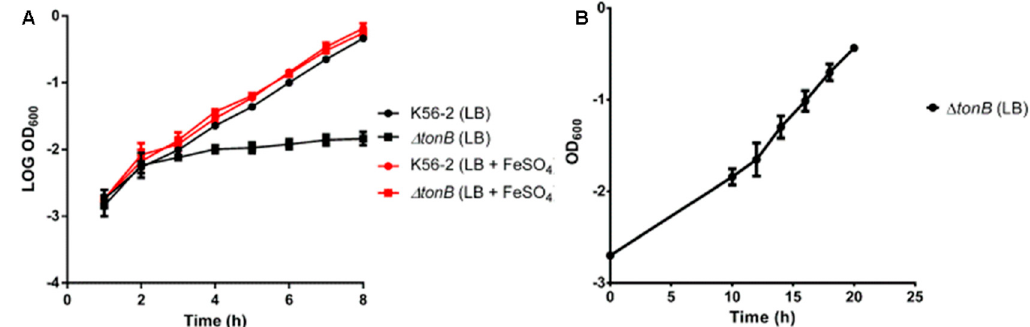
Figure 1. GAP001 impaired growth is rescued by iron supplementation. Overnight cultures of wild type and GAP001 were diluted 1:100 in 30 mL of LB broth (black circle and black square) or 30 mL of LBG + 200 μ M FeSO 4 (red circle and red square), OD 600 was determined every hour. Growth curves up to 8 h ( A ). GAP001 growth curve up to 20 h ( B ).